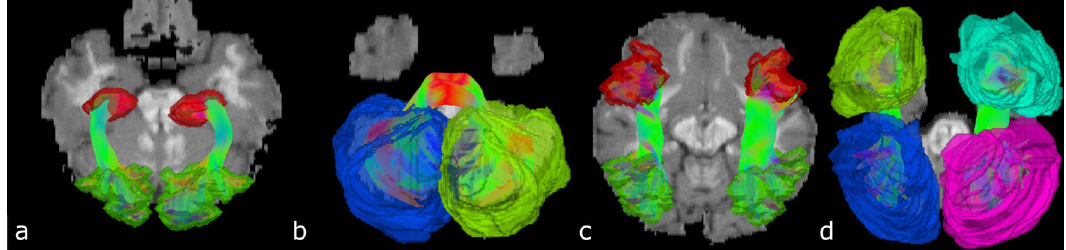
Figure 4. Examples of possible endpoint ROIs. ( a ) OR, ( b ) MCP, ( c ) and ( d ) SLF. Various degrees of dilation were tested. Bigger ROIs such as in B and D were necessary to score adequately all submitted tractograms. Original 2015 scores Updated 2015 scores Mean (old bundle masks) (new bundle